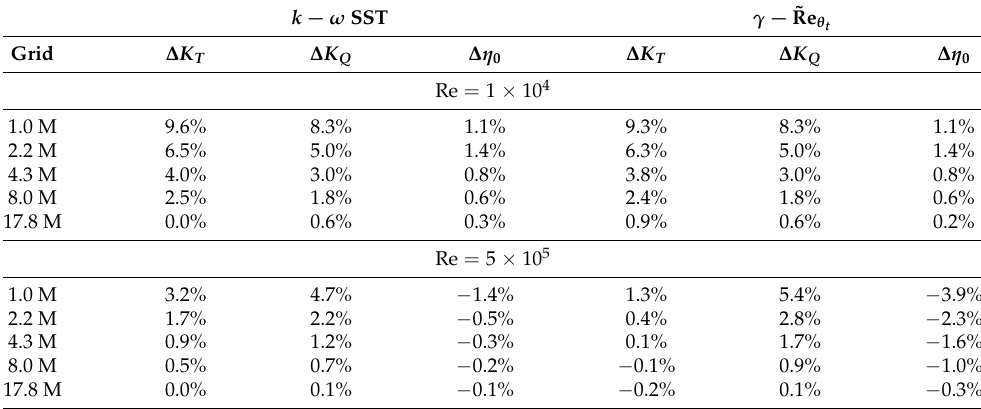
Table 4. Variation of the force coefficients with grid density compared to the finest grid at J = 0.568. Re = 1 × 10 4 , 5 × 10 5 and 1 × 10 7 . M denotes